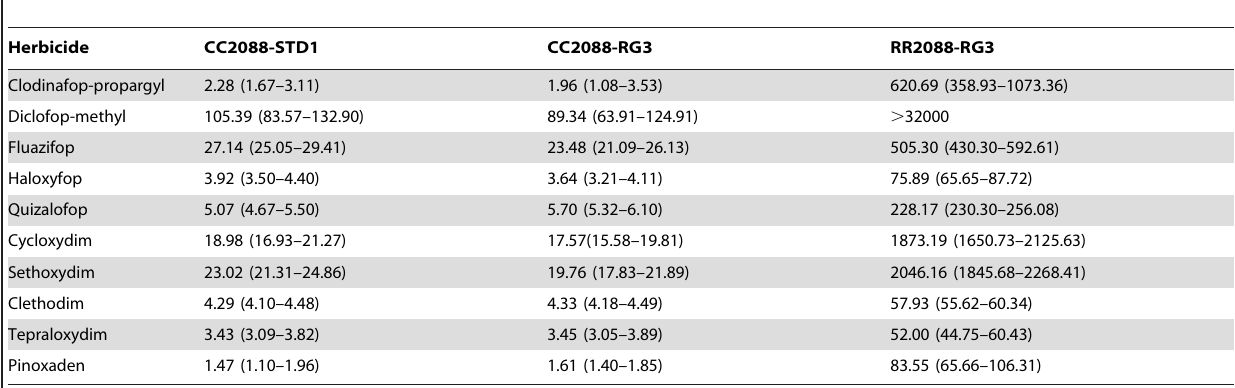
Table 2. Estimated GR 50 values for 10 ACCase inhibiting herbicides and different 2088 ACCase